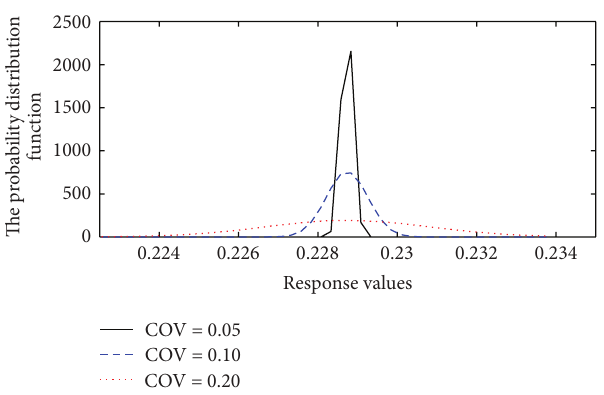
Figure 7: The pdf at point 𝐶 for different values of COV.